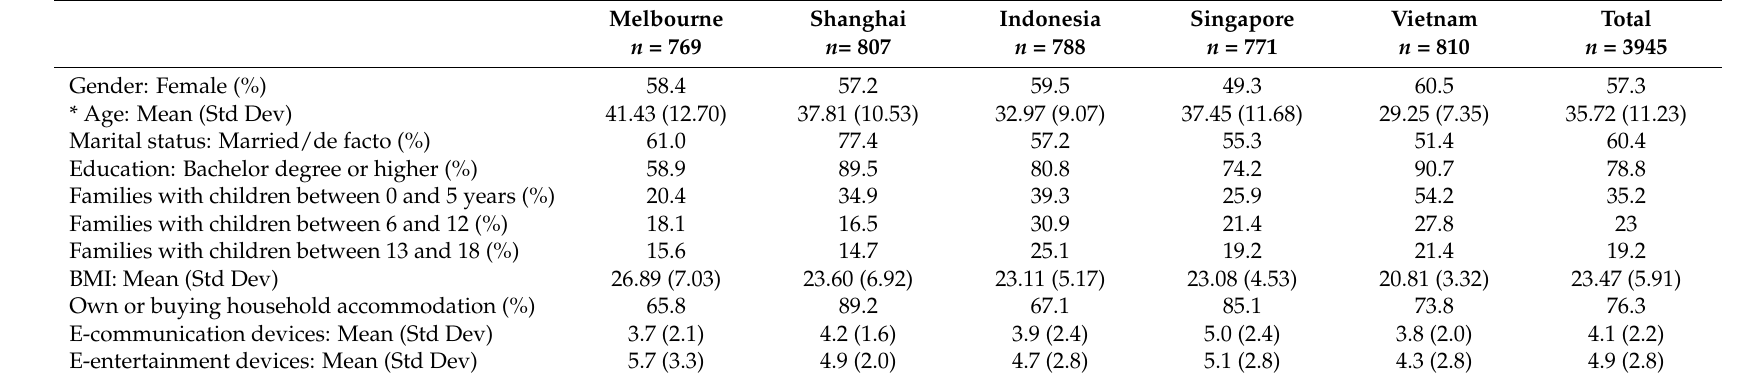
Table 1. The demographic characteristics, BMI and ownership of communication devices of the samples.